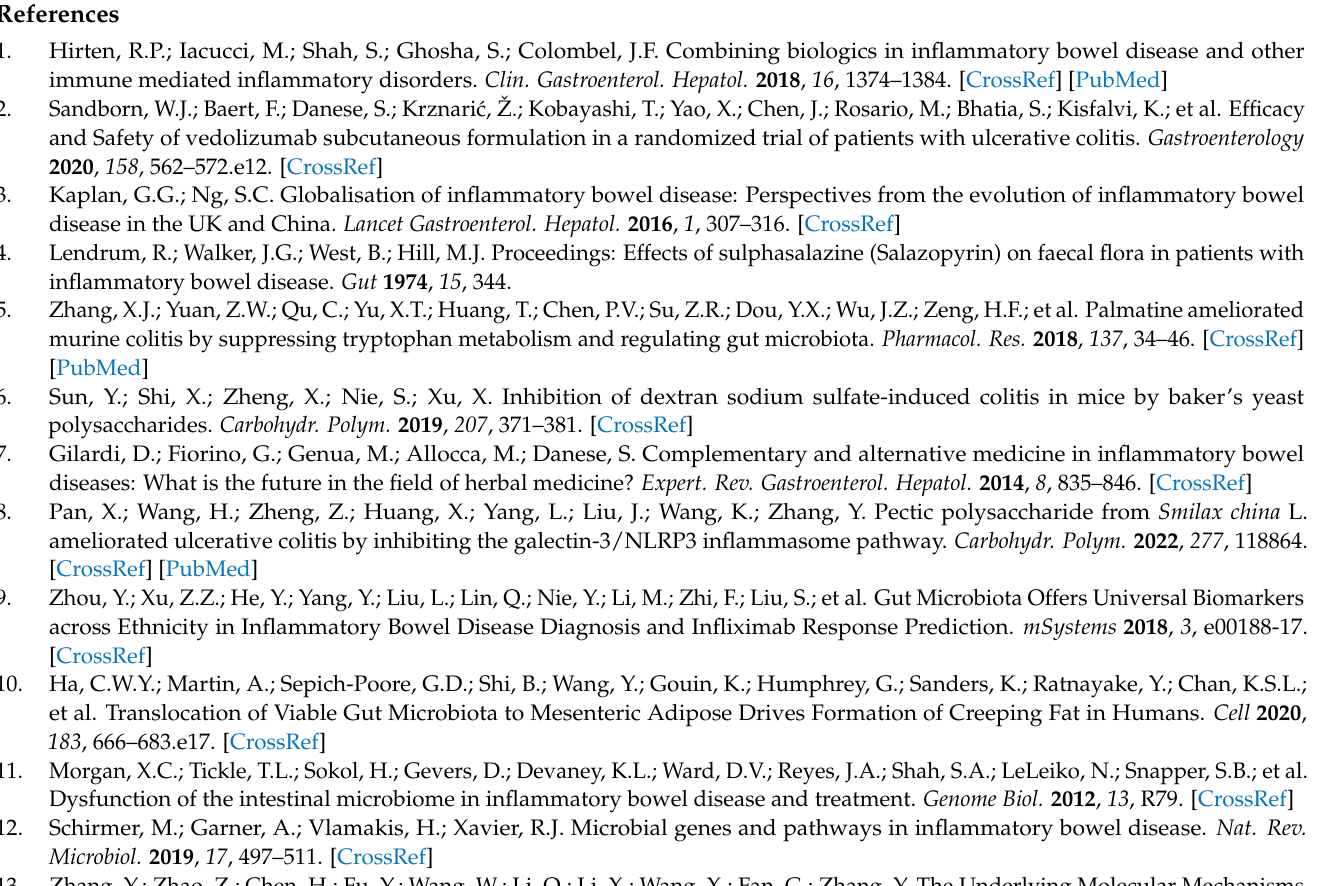
Figure S2. DSS mice with the typical symptoms of UC, such as diarrhea and bloody stool. ( A ) DSS Figure S3. Alpha diversity analysis of polysaccharide-treated microbiota. ( A , B ) Pan/core curves, ( C ) Rarefaction curves, and ( D ) Shannon index. Table S1. Composition of the diets (g/kg). Table S2. Sequencing data summary and alpha community